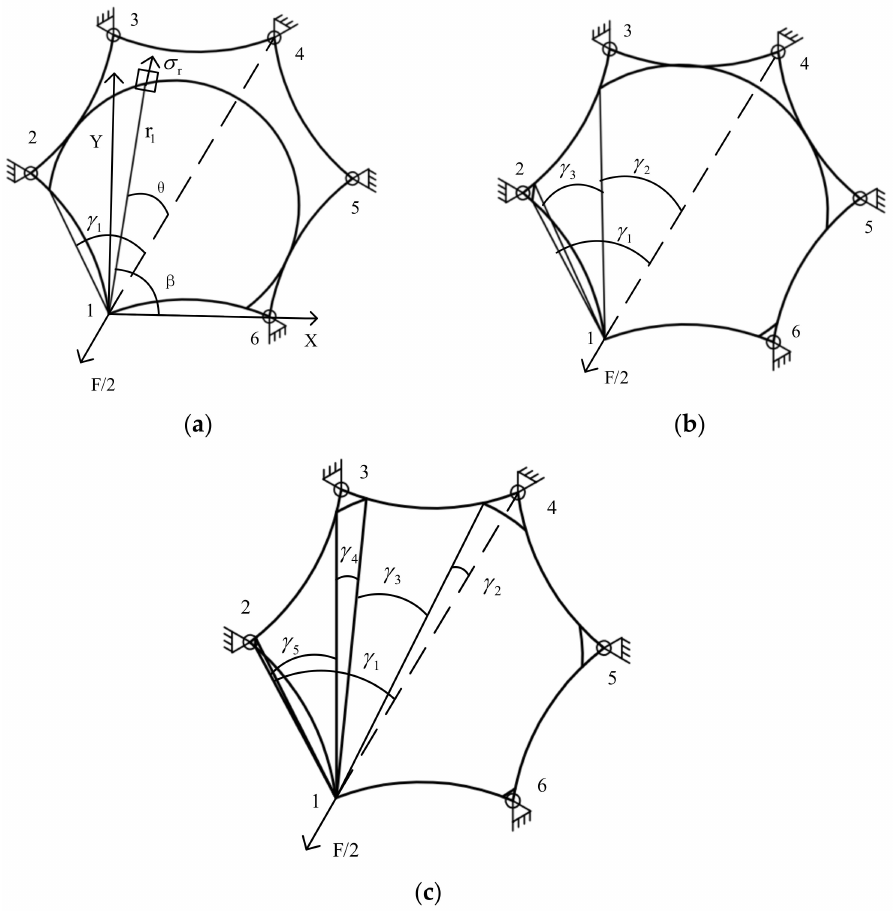
Figure 3. Corner point tensioning ortho-hexagonal stress area division. ( a ) Region I stress arc distribution;( b ) region II stress arc distribution; ( c ) region III stress arc